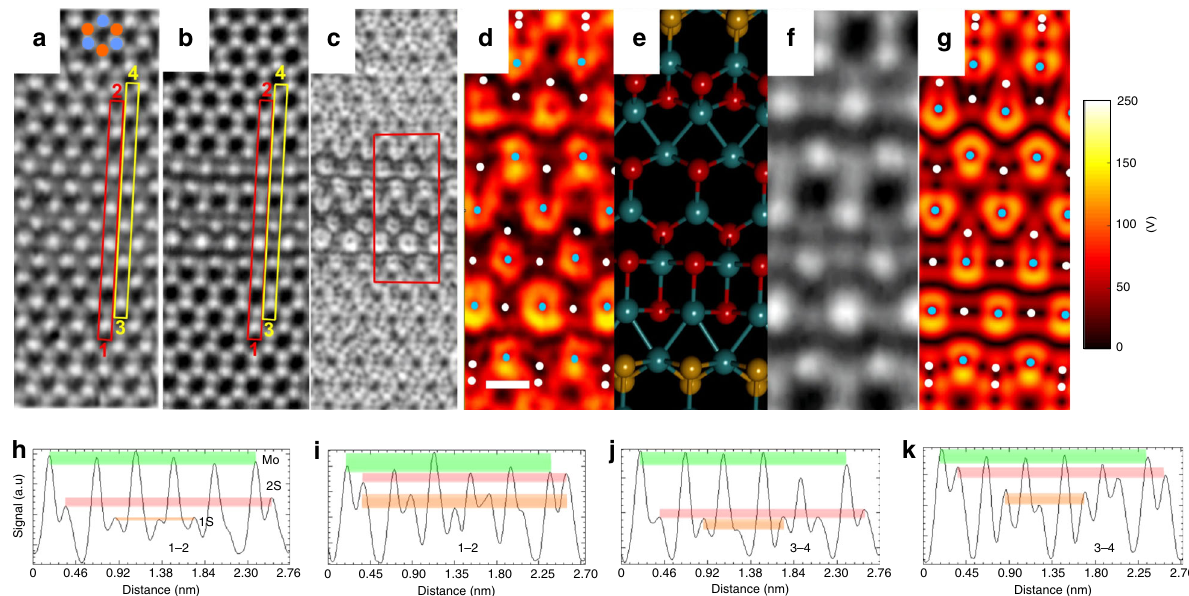
Fig. 6 High-resolution 4D STEM of larger width line vacancy channels in MoS 2 . a LAADF image of complex line defect in MoS 2 reconstructed from 4D STEM data. Scale bar indicates 0.5 nm. Cyan spots indicate Mo atom sites and orange indicates 2S positions. b Ptychographic phase of a complex line defect area in MoS 2 reconstructed from 4D STEM data. c | E ┴ | map around complex line defect in MoS 2 reconstructed from 4D STEM data. d Magni fi ed view of the red boxed area in c , plotted in color. Cyan dots indicate Mo atom sites and white dots indicate S atoms. Scale bar indicates 0.2 nm and is applicable to panels d − g . e Atomic model matching the structure in d . f Ptychographic phase map of the same area as in d . g DFT-calculated | E ┴ | map, based on the atomic model in e , plotted in color. Cyan dots indicate Mo atom sites and white dots indicate S atoms. h − k Normalized line pro fi les taken from h red box in a , i yellow box in a , j red box in b , k yellow box in b . Green bands indicate the Mo level, red bands indicate the 2S level and orange band indicates the 1S